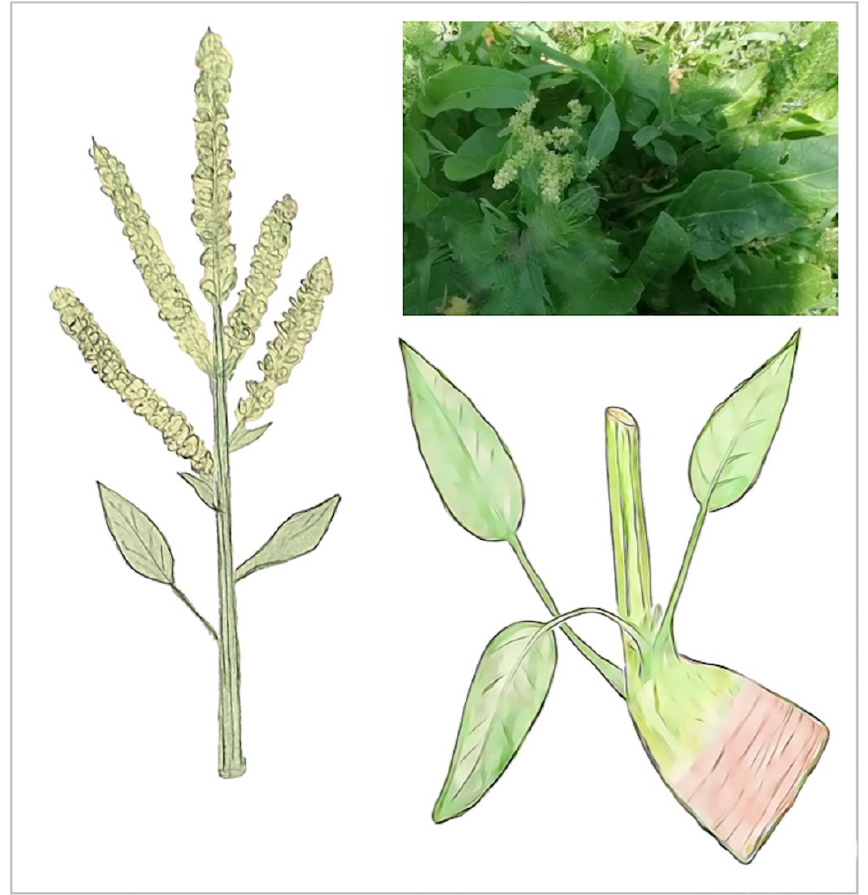
Figure 6. Unknown Beta sample, Vardenyats Mountain Pass, Gegharkunik marz, RA. All recorded differences between the found unknown species and the neighbor B. macrorhiza plants are listed in Table 4. Table 4. Morphological differences between B. macrorhiza and the Unknown Beta .